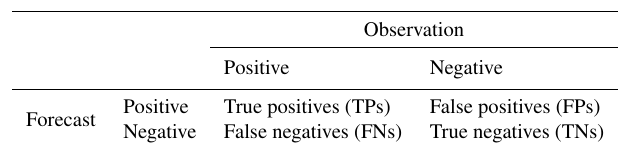
Table 2. Confusion matrix for ROC curves